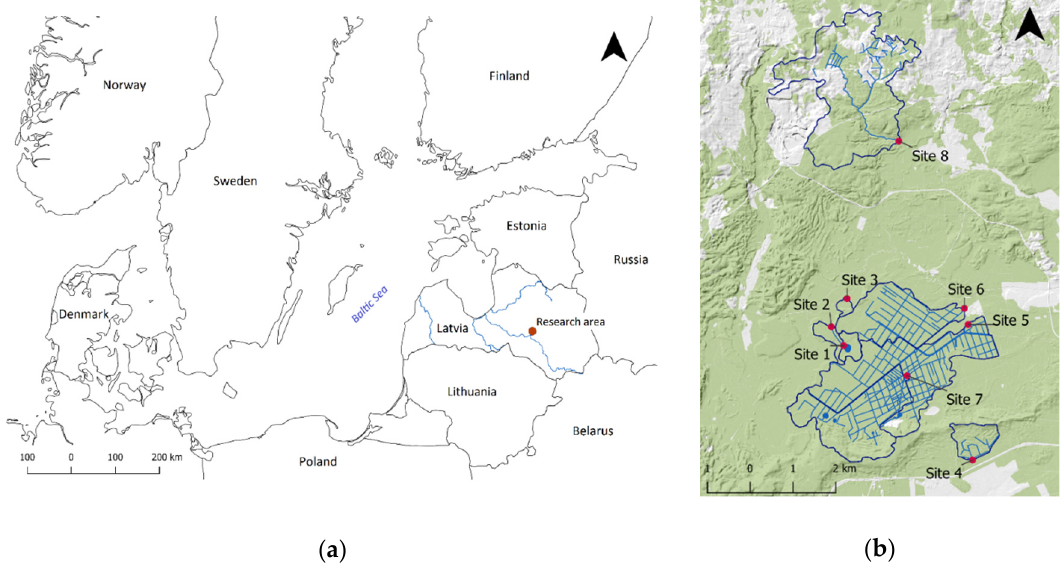
Figure 1. Location of the research area in the Baltic Sea region ( a ); Locations of study sites and catchment areas ( b ). The dark blue lines in ( b ) represent the sub-catchment boundaries while the light blue lines represent the drainage ditches. Table 1. Characterization of the sampling sites, including the sampling site coordinates, the type of disturbance, the character of the ditch/stream (e.g., natural versus drainage ditch) and carbon, nitrogen, sulphur and phosphorus concentrations in